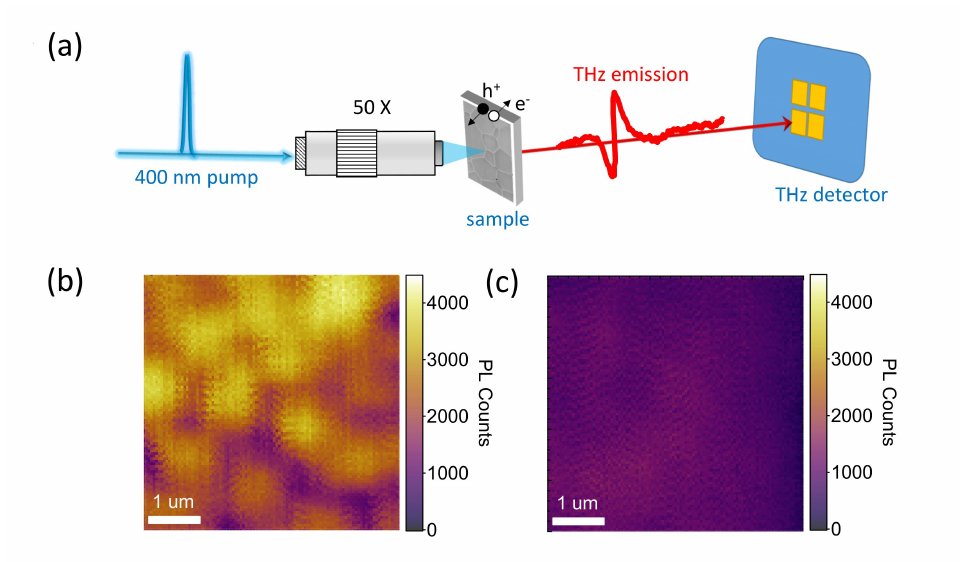
Figure 1. ( a ) Schematic illustration of the LTEM setup in transmission geometry. The photoexcited charges move in the direction perpendicular the sample surface as to be discussed later. PL images of MAPbI 3 perovskite thin film sample with ( b ) and without ( c ) Pb(SCN) 2 additives at room temperature. The scale bar is 1 µ